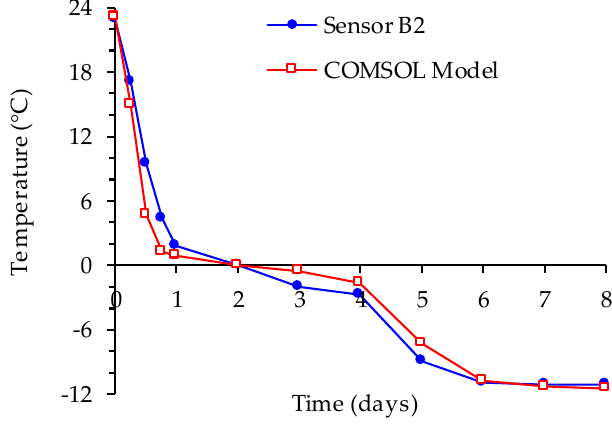
Figure 5. Model calibration using data from sensor B2 in the cooled barrel.